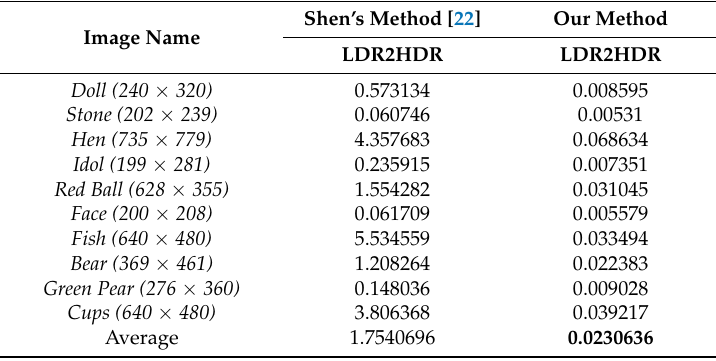
Table 7. MATLAB Processing Time (in Second).